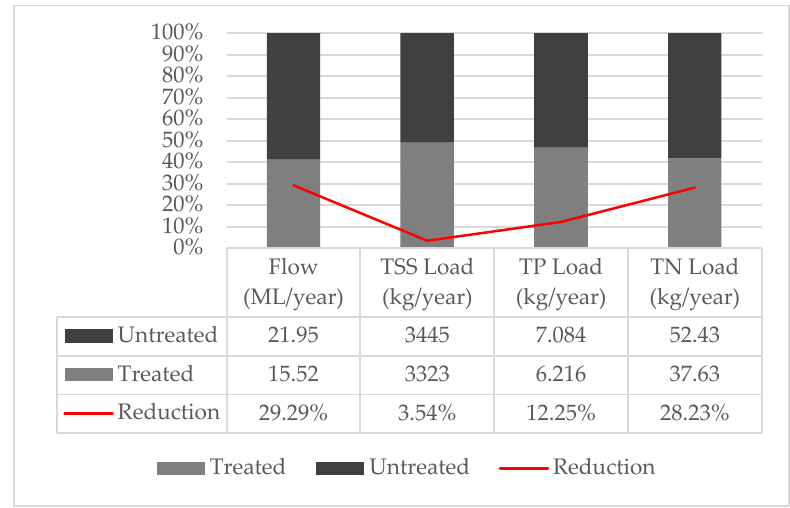
Figure 7. The green roof treatment effectiveness using the land use node approach.